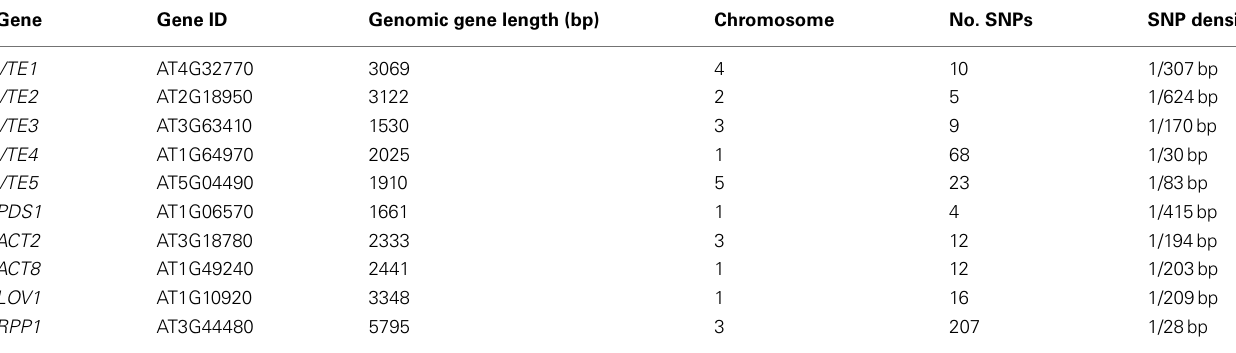
TableA4 | SNP densities with in A. thaliana tocopherol genes by using POLYMORPH (Fitz, J. et al., personal